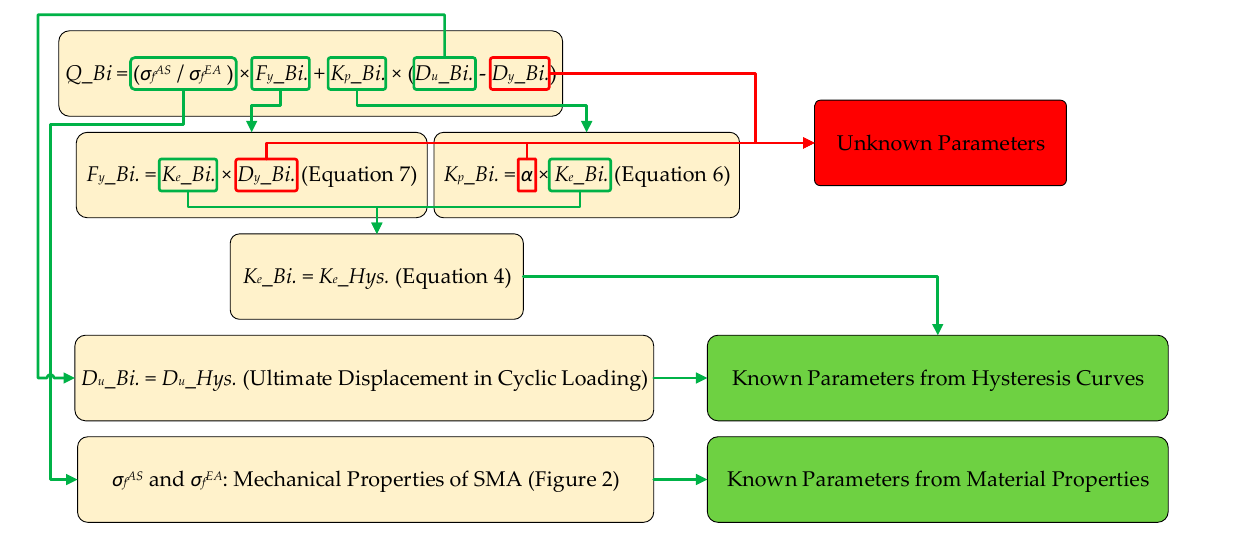
Figure 15. The process of Q_Bi . determination.